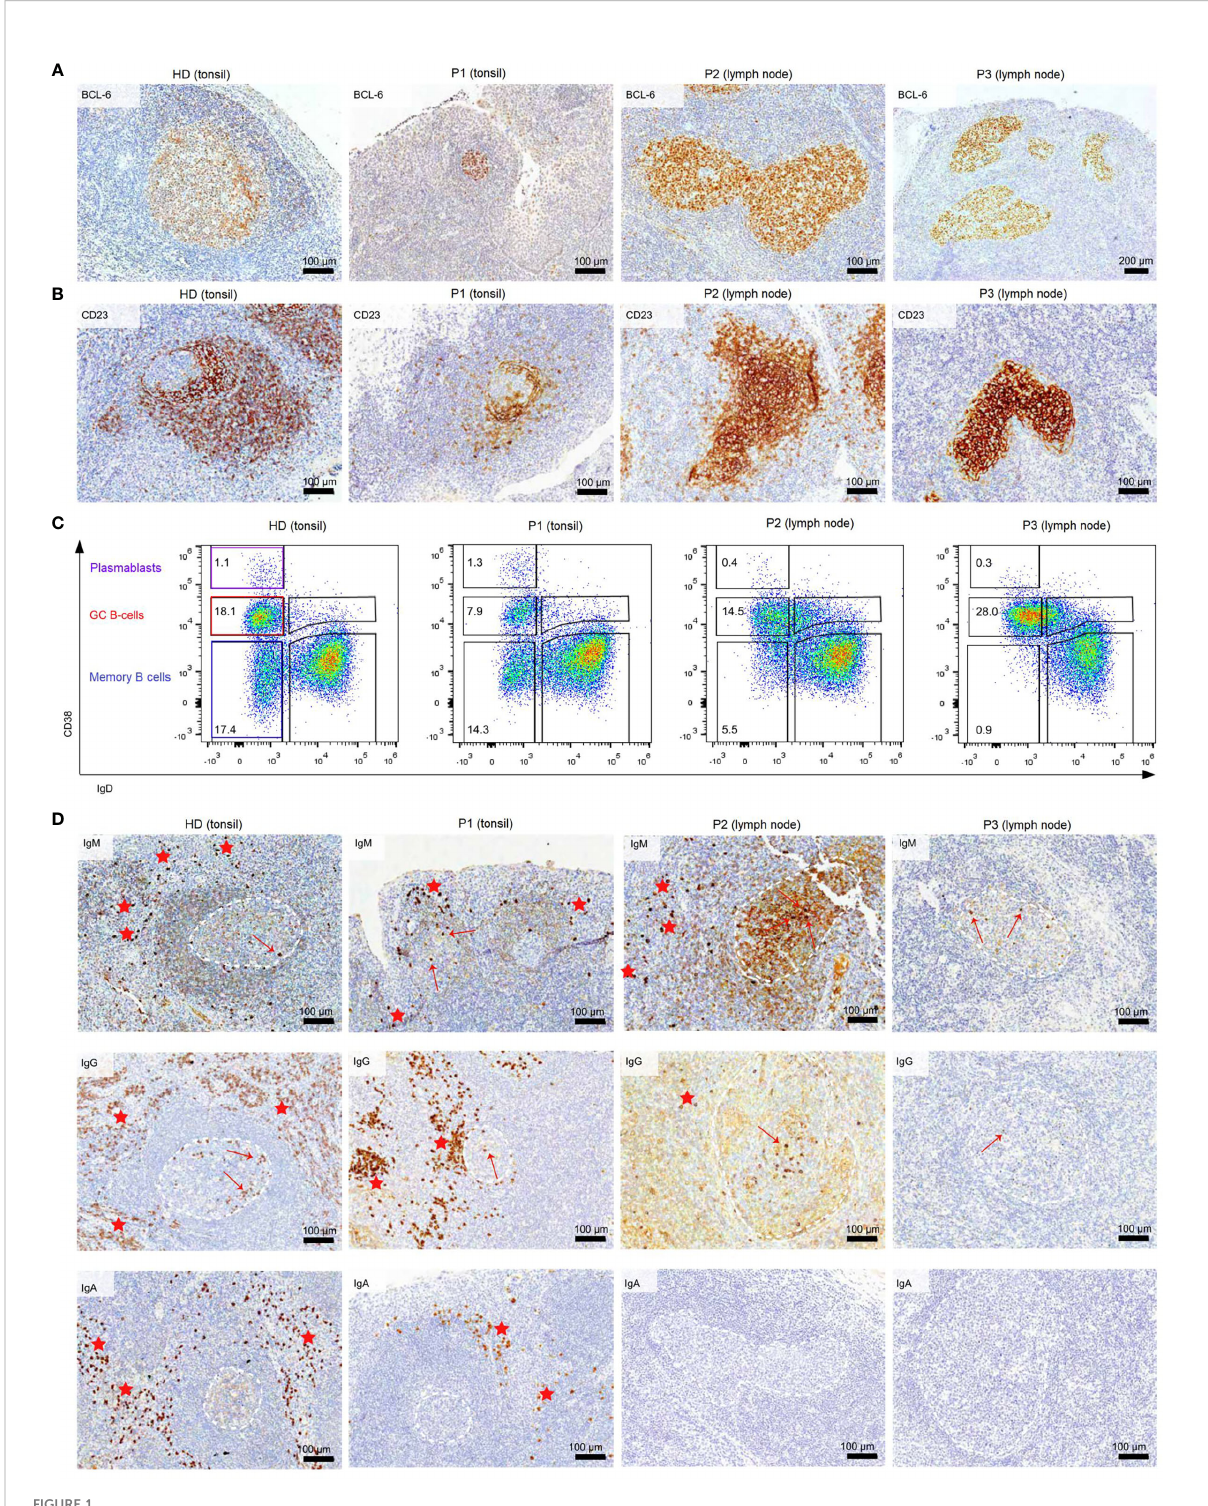
FIGURE 1 Dysmorphic GCs and impaired B-cell differentiation in CVID patients (A) BCL6 staining of tonsils and lymph nodes of HDs and CVID patients. (B) CD23 staining of tonsils and lymph nodes to highlight follicular dendritic cells present in the GC light zone as an indicator of GC polarization. (C) Frequency of GC, memory B cells, and PB in total B cells of secondary lymphoid organs. (D) Clusters of extrafollicular IgM, IgG, and IgA plasma cells in secondary lymphoid organs are highlighted by red stars, intrafollicular plasma cells by a red arrow. GCs are marked with dashed white lines. The light brown staining in the GC of P2 is due to background staining and does not represent plasma